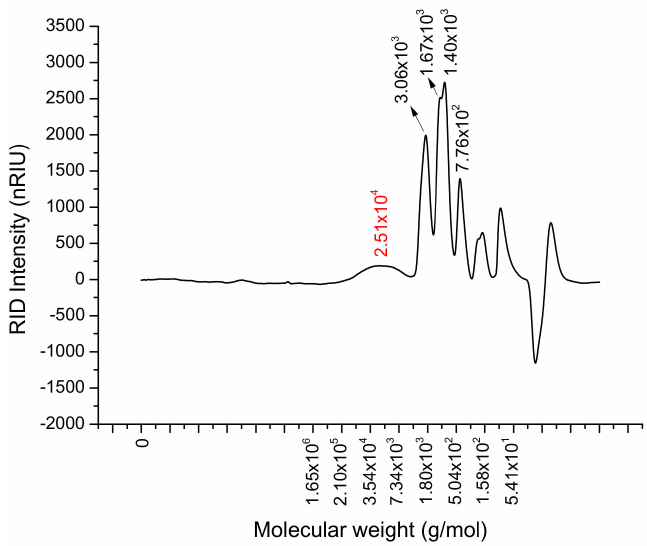
Figure 1. High-pressure size exclusion chromatography (HPSEC) chromatogram of polysaccharides